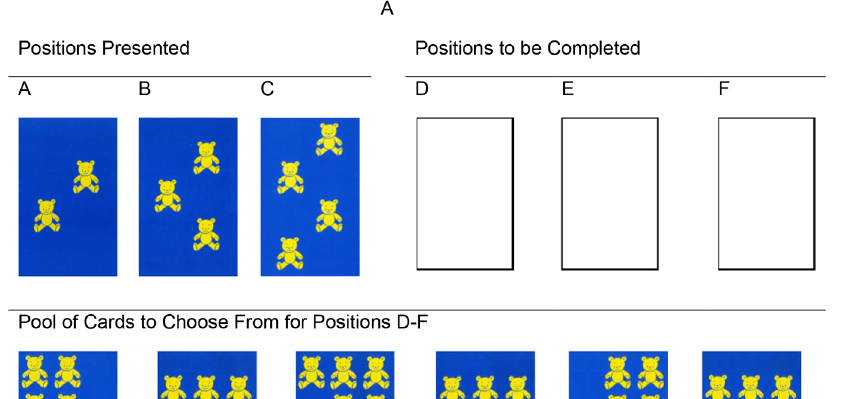
depicted on each card, and compare the numbers.” (the instruction is translated from German). Thus, to complete the sequence in Trial 1, children had to choose the card with 5, then the one with 6, and finally the one with 7 bears to correctly complete this trial. Trial 4 requires to count backwards and to leave a blank with a blank